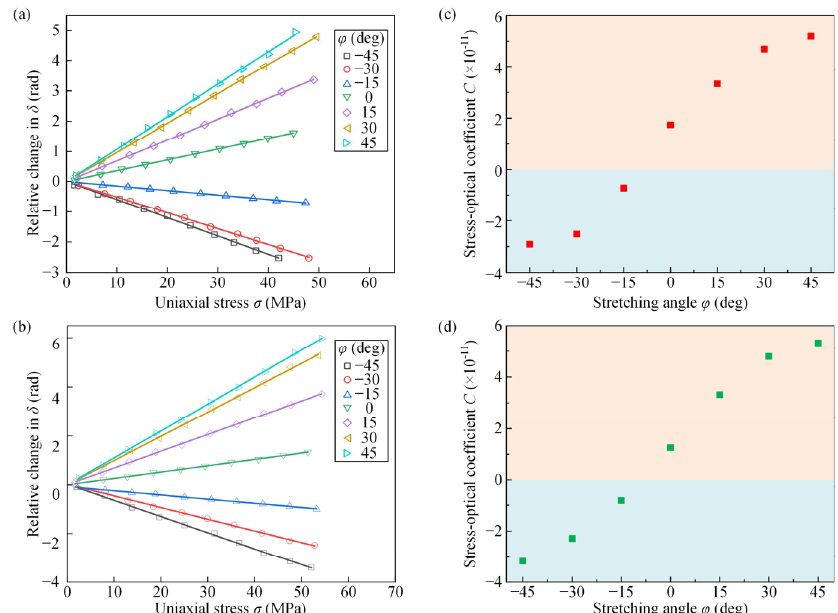
Figure 5. The relation between the relative change in the isochromatic phase and uniaxial stress of PET films with different stretching angles in ( a ) transmission photoelastic experiments and ( b ) reflection photoelastic experiments; ( c , d ) are the corresponding stress-optical coefficients.